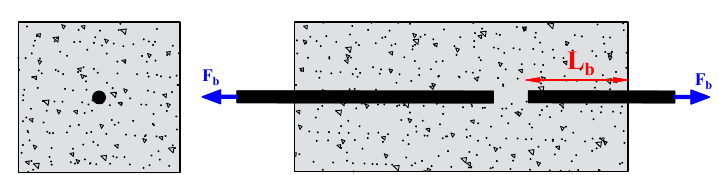
Figure 7. Pull-out test.